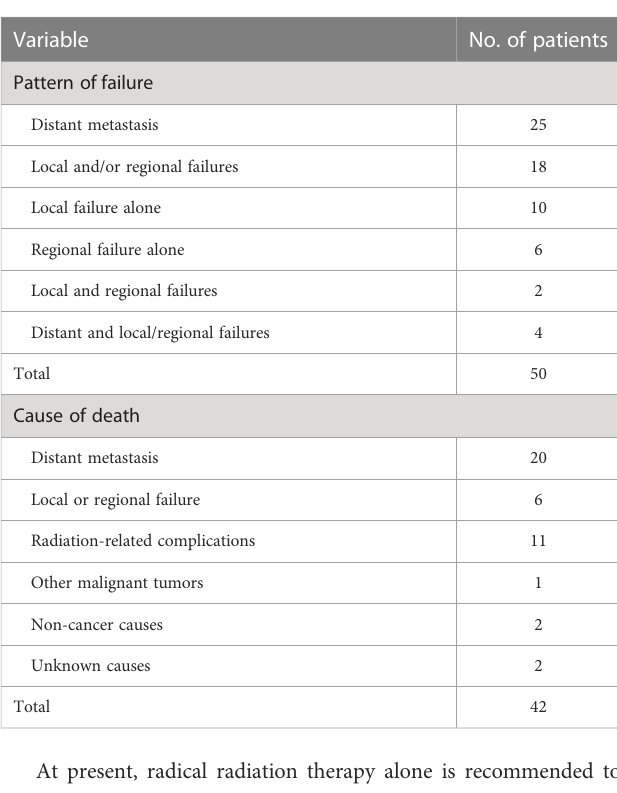
TABLE 3 Pattern of failures and cause of